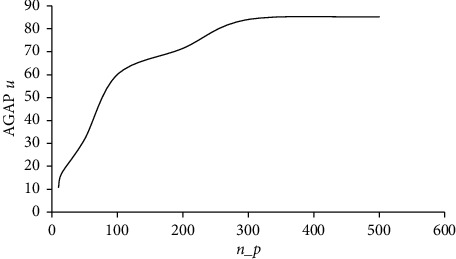
Variation of AGAPu according to np.